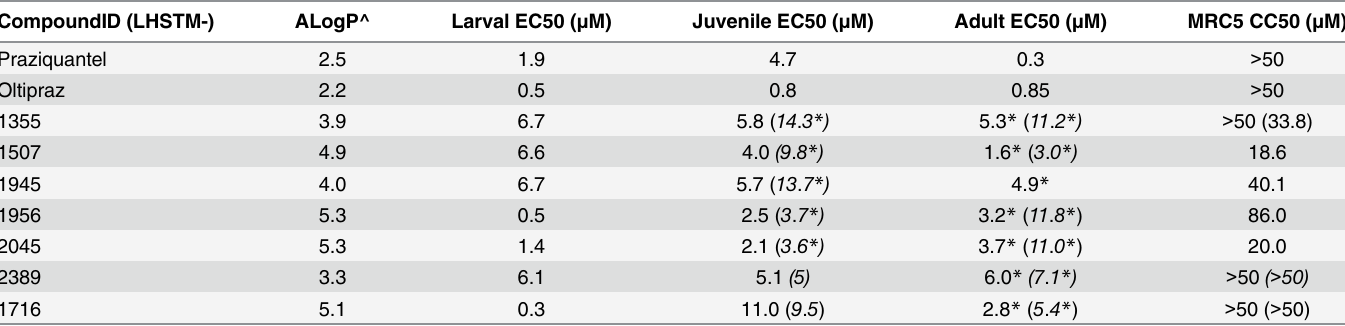
Table 3. Activity data for compounds of